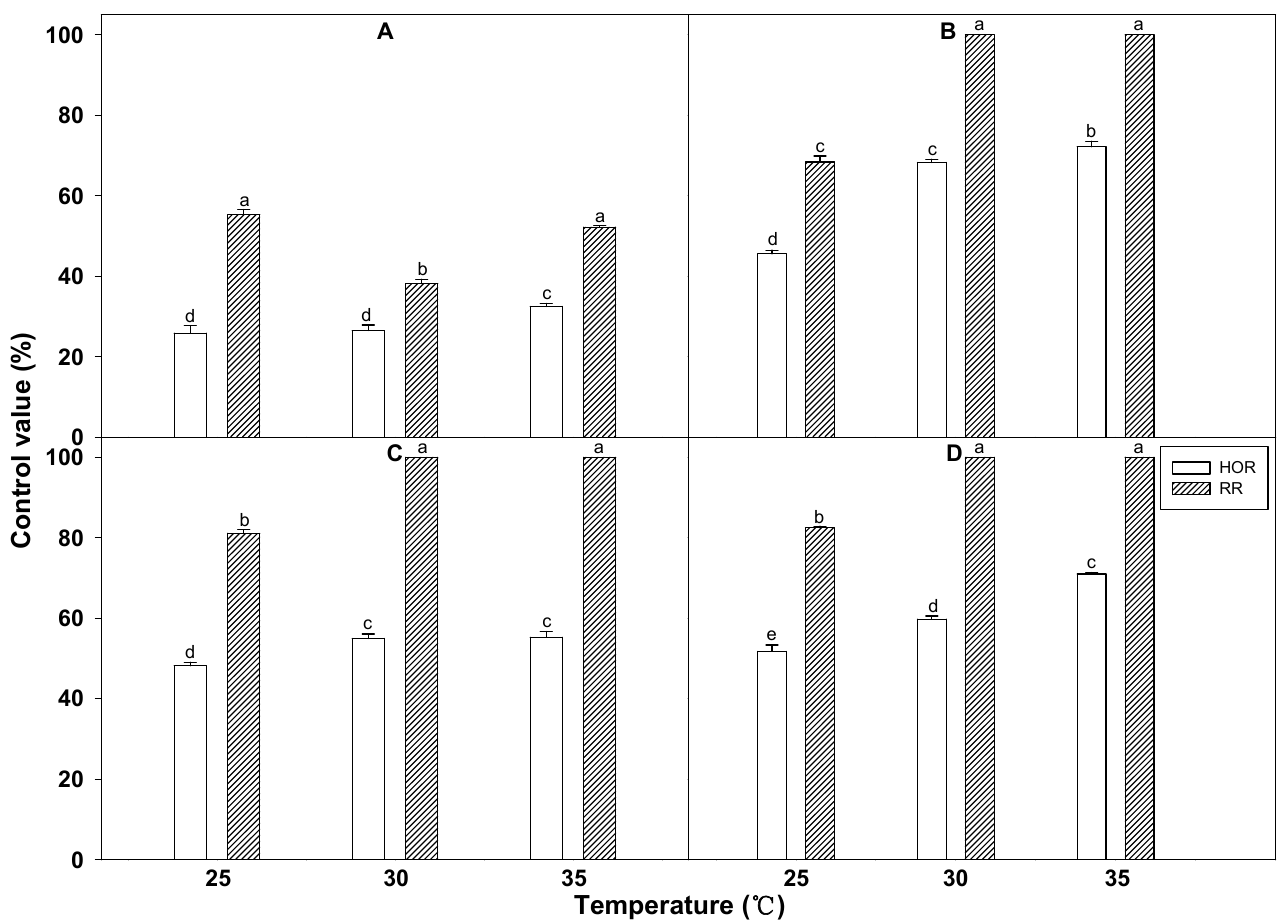
Figure 9. Control value (%) of A. patulus in response to foliar herbicides ( A . glyphosate isopropylamine; B . glufosinate- ammonium; C . bentazone; D . mecoprop) t different temperatures in a growth chamber. HOR: Half of the recommended rate; RR: Recommended rate. Means within bars followed by the same letters are not significantly different at the 5% level according to Duncan’s Multiple Range Test. Error bars represent SE.